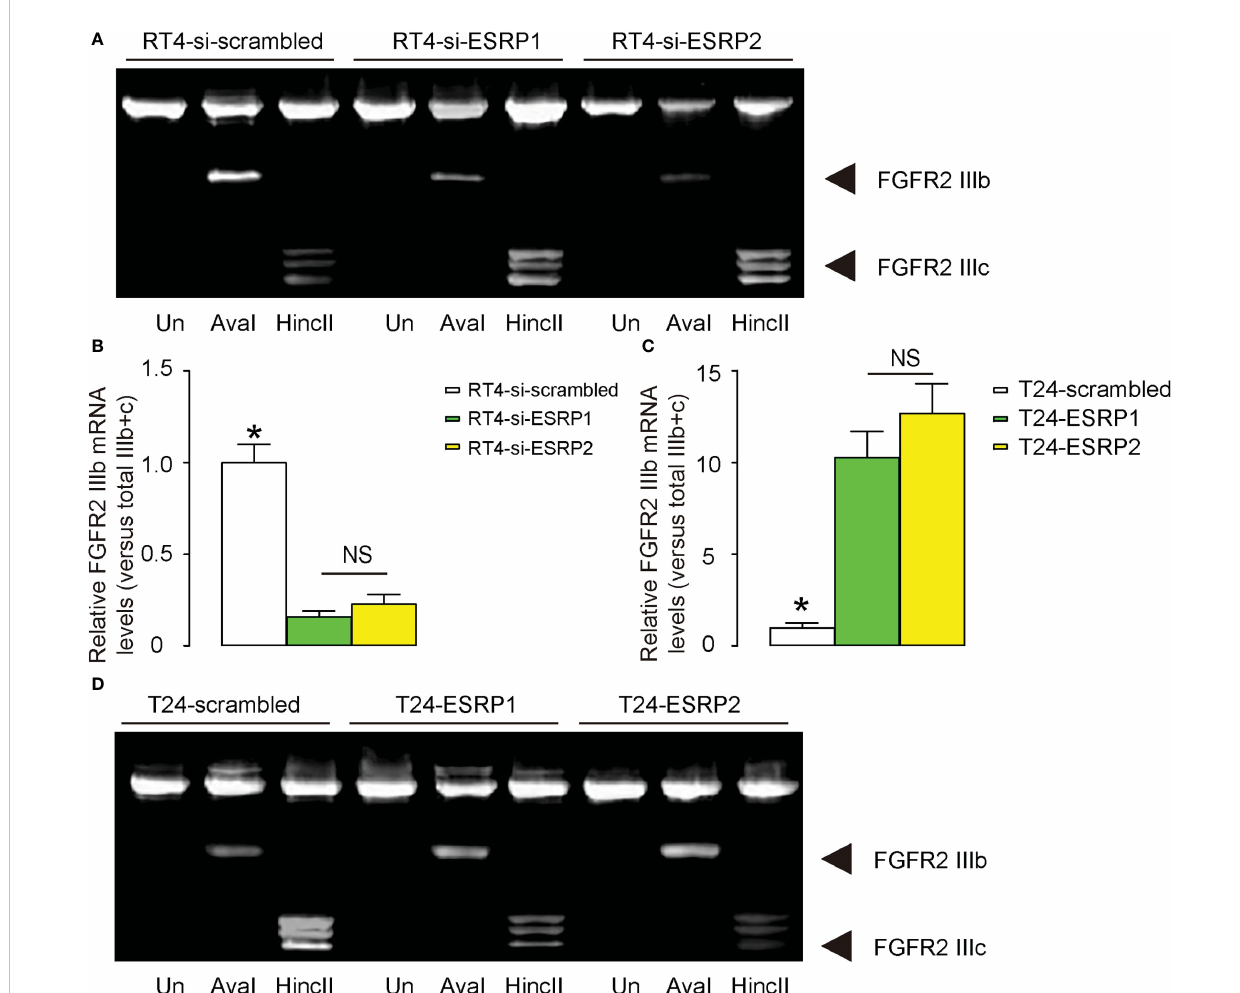
FIGURE 4 Regulation of BC cell invasiveness by ESRP1/2 may be through shifting the epithelial splice form of FGFR2 IIIb to the mesenchymal splice form of FGFR2 IIIc. (A, B) The levels of FGFR2 IIIb and FGFR2 IIIc mRNA in Aval and HincII-digested PCR product for FGFR2 in transfected RT4 cells, shown by representative gel (A) , and by quanti fi cation of the ratio of FGFR2 IIIb to the combined FGFR2 IIIb and FGFR2 IIIc as the levels of the epithelial versus mesenchymal splicing of FGFR2 (B) . (C, D) The levels of FGFR2 IIIb and FGFR2 IIIc mRNA in Aval and HincII-digested PCR product for FGFR2 in transfected T24 cells, shown by quanti fi cation of the ratio of FGFR2 IIIb to the combined FGFR2 IIIb and FGFR2 IIIc (C) , and by representative gel (D) . *p<0.05. NS: non-signi fi cant.